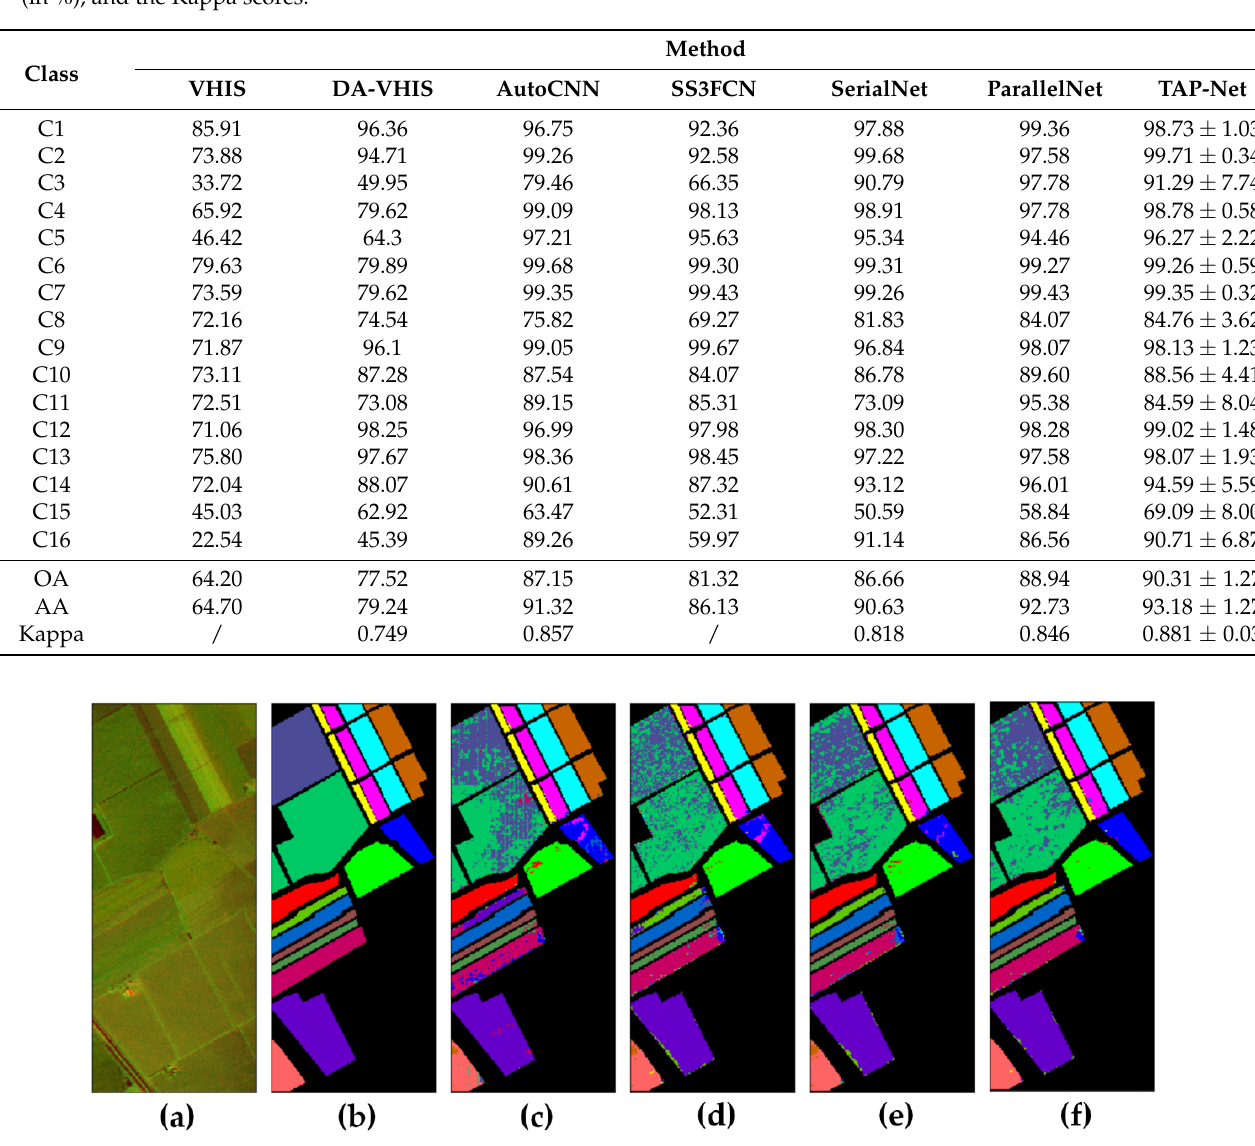
Figure 9. Classification maps by different models for Salinas Valley: ( a ) false color image, ( b ) ground truth, ( c ) SS3FCN, ( d ) SerialNet, ( e ) ParallelNet, and ( f )